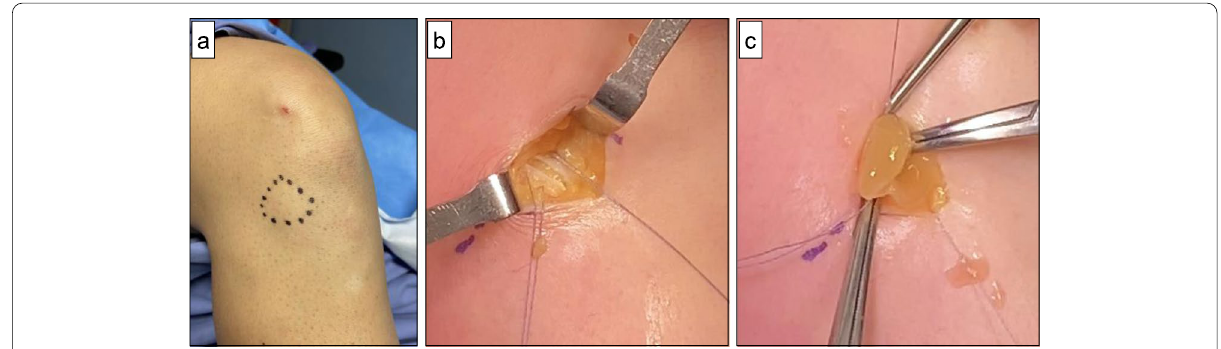
Fig. 3 The application of autologous membrane. a Parameniscal cyst is marked with a sterile skin-marker. b A Z-shaped shaped incision is performed on the iliotibial band. Subsequently, a horizontal-oblique incision of the capsule is performed over the joint line in correspondence of the cyst. The cyst is evacuated c ) The autologous platelet-rich fibrin matrix is sutured side-to-side to the adjacent capsule with an absorbable